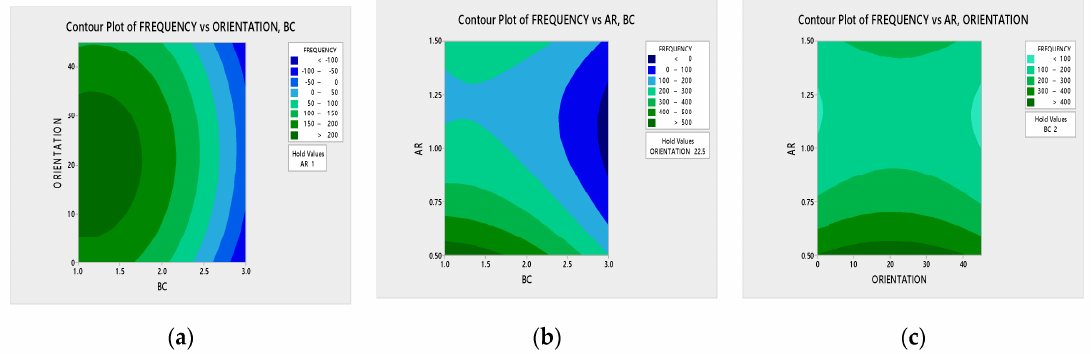
Figure 6. Contour plots on frequency versus parameters. ( a ) ply-orientation vs. boundary condition, ( b ) aspect ratio vs. boundary condition, ( c ) aspect ratio vs.